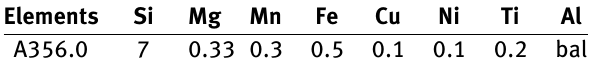
Table 1: Chemical composition of cast 356.0 Elements